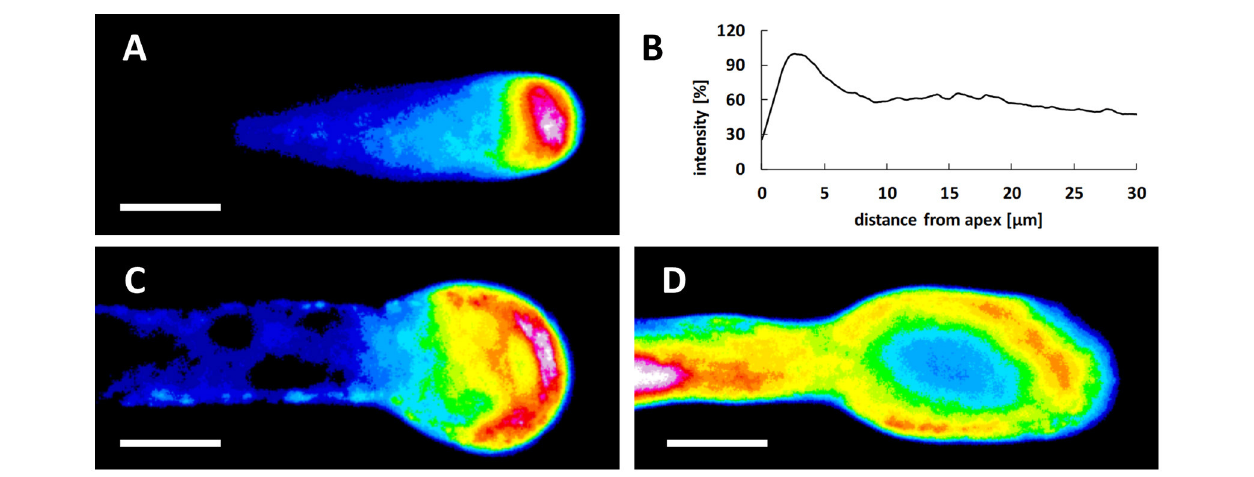
FIGURE 4 | Treatment with Spm dramatically modifies the pH gradient at the pear pollen tube apex. (A) In controls, pollen tubes have a tip-oriented pH gradient with an acidic region located at the tube apex. The pH acid region disappears shortly after 5–10 µ m from the apex and only a weak background signal can be observed. (B) The data is confirmed by the relative measurement of the fluorescence intensity that is representative of three independent experiments. (C) At the balloon stage of Spm-treated pollen tubes, the pH gradient changes and the highest H + concentration is redistributed throughout the surface of the swelling apex. (D) At the shovel stage, H + concentration is approximately homogeneous throughout the new enlarged pollen tube. No H + accumulation was observed at the apex of the new pollen tube. Bar = 10 µ